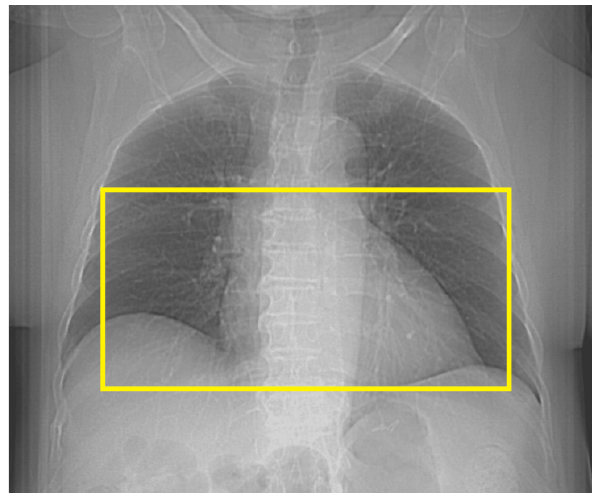
Fig. 1. Computed tomography scout; the yellow box shows the cranio-caudal extent of the CT